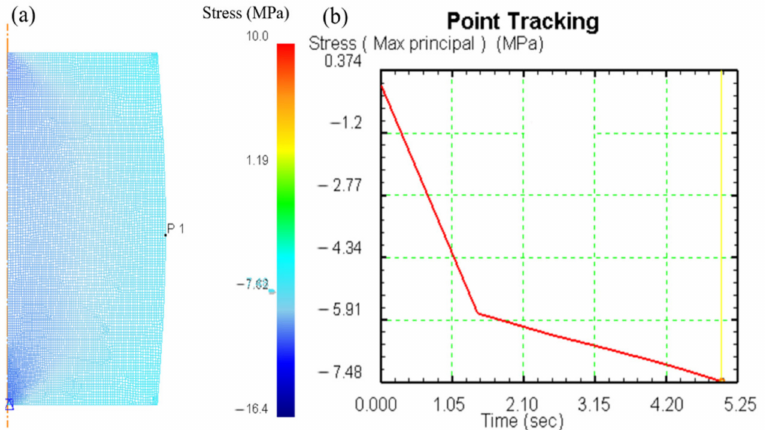
Figure 4. ( a ) Compression stress distribution of the aluminum sleeve in the CHCM process, and ( b ) point tracking of the stress state of at the apex of the drum-shaped area.